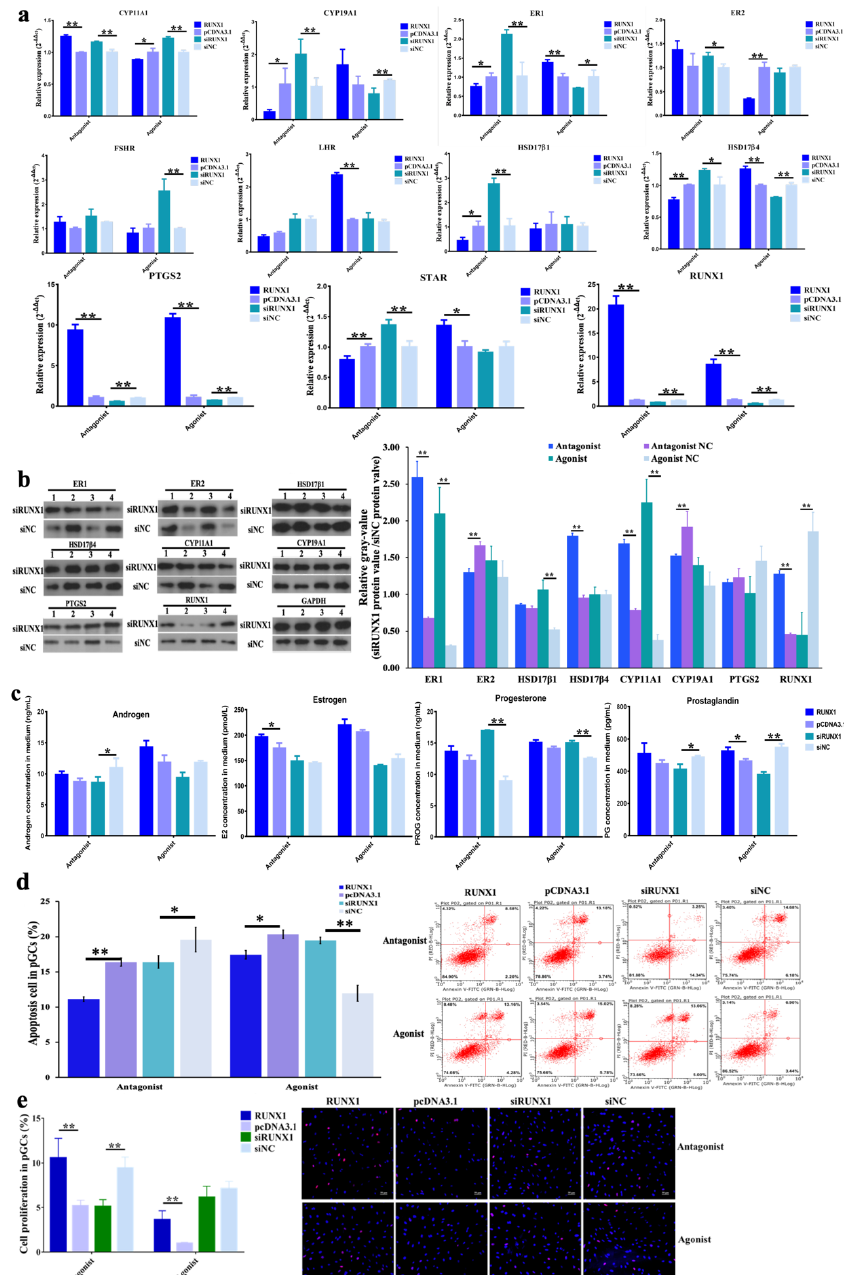
Figure 6. The influence of the H3K27me3-RUNX1 signal on steroidogenesis, cell apoptosis and proliferation in pGCs. ( a ) The expression patterns of steroidogenesis-related genes when RUNX1 was over-expressed and knocked down, and also when treated with antagonist GSK-126 or agonist GSK-J4 at the same time. The * indicates p < 0.05 and ** indicates p < 0.01. ( b ) Protein translation of RUNX1, PTGS2, ER1, ER2, HSD17 β 1, HSD17 β 4, CYP11A1, and CYP19A1. The numbers 1, 2, 3, and 4 indicate treatments with antagonist GSK-126, antagonist-NC, agonist GSK-J4, and agonist-NC. ( c ) The concentrations of androgen, estrogen, prostaglandin, and progesterone in the situation of interfering with the H3K27-RUNX1 signal in pGCs. ( d ) The e ff ect of RUNX1 along with antagonist GSK-126 or agonist GSK-J4 on pGC apoptosis. The pGCs apoptotic proportion in the column plot is a visualization from the sum of the upper and lower right quadrants in the scatter plot. ( e ) The e ff ect of RUNX1 along with antagonist GSK-126 or agonist GSK-J4 on pGCs proliferation. The proportion of proliferated cells in the column is equal to the ratio of total proliferated cells / total